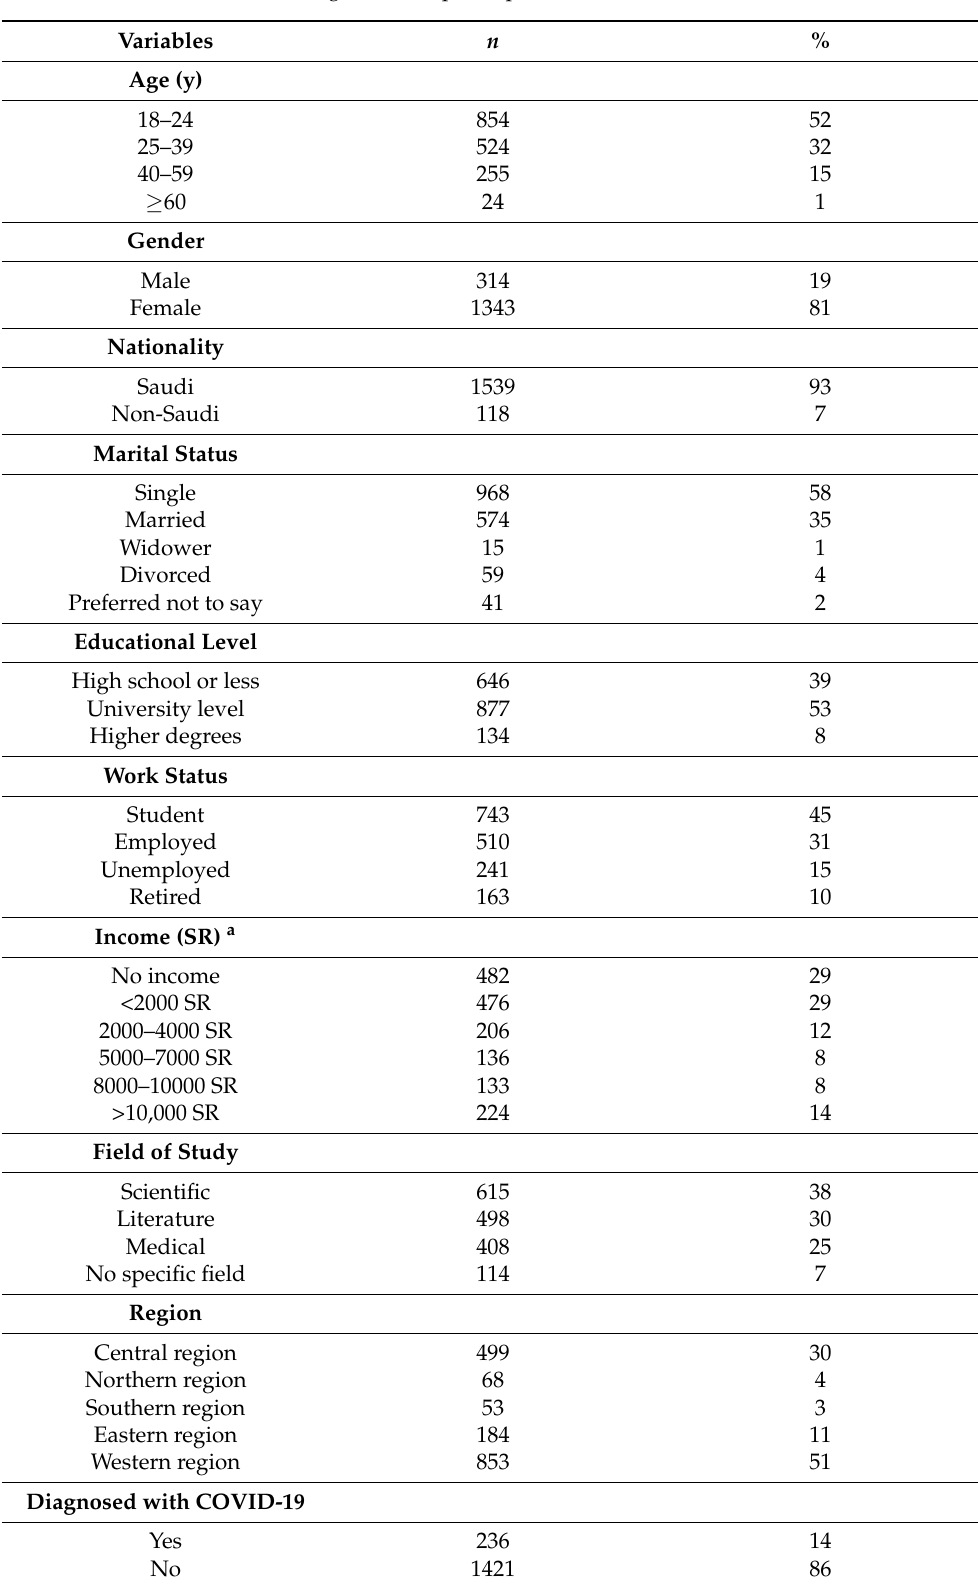
Table 1. Characteristics and backgrounds of participants ( n =